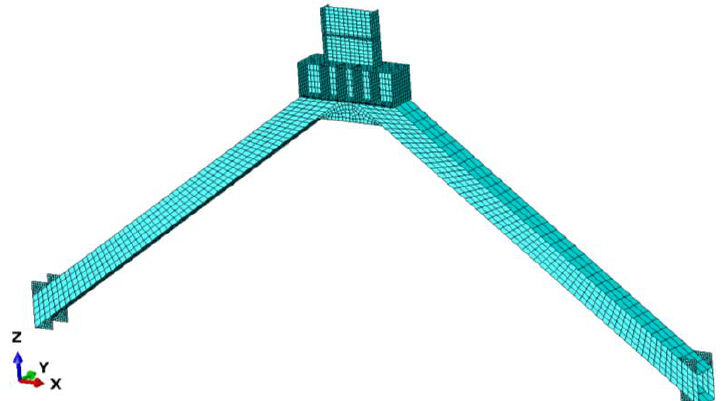
Figure 5. Grid division of eccentric support.